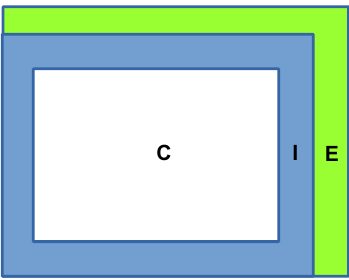
Figure 1. The domain of the LAM model is composed of three zones: a physical central zone (C), an intermediate zone (I) where the lateral-boundary conditions are imposed by a relaxation, and the extension zone (E) where artificial periodic extensions of the fields are